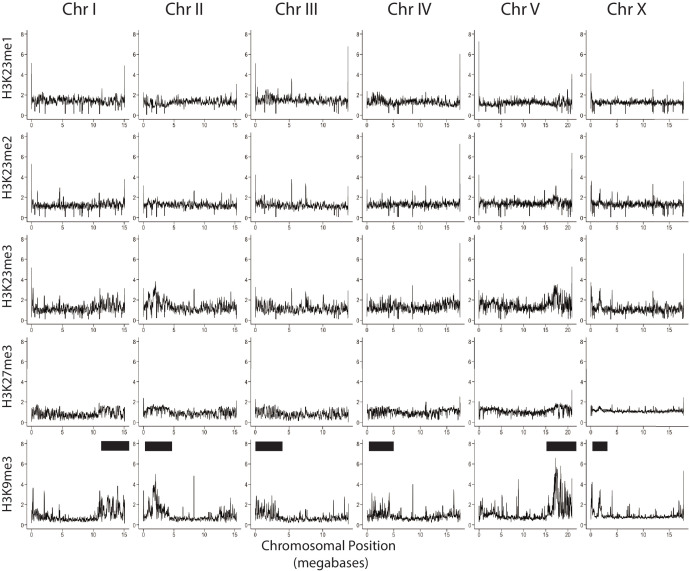
Whole Chromosome Comparison of H3K9me3/H3K27me3/H3K23me3/H3K23me2/H3K23me1.Relative enrichment of H3K23me1, H3K23me2, H3K23me3, H3K27me3 and H3K9me3 (top to bottom) ChIP-seq signal to input (y axis) for each chromosome (x axis). Black bar indicates approximate location of meiotic paring centers. Signal is normalized to sequencing depth.